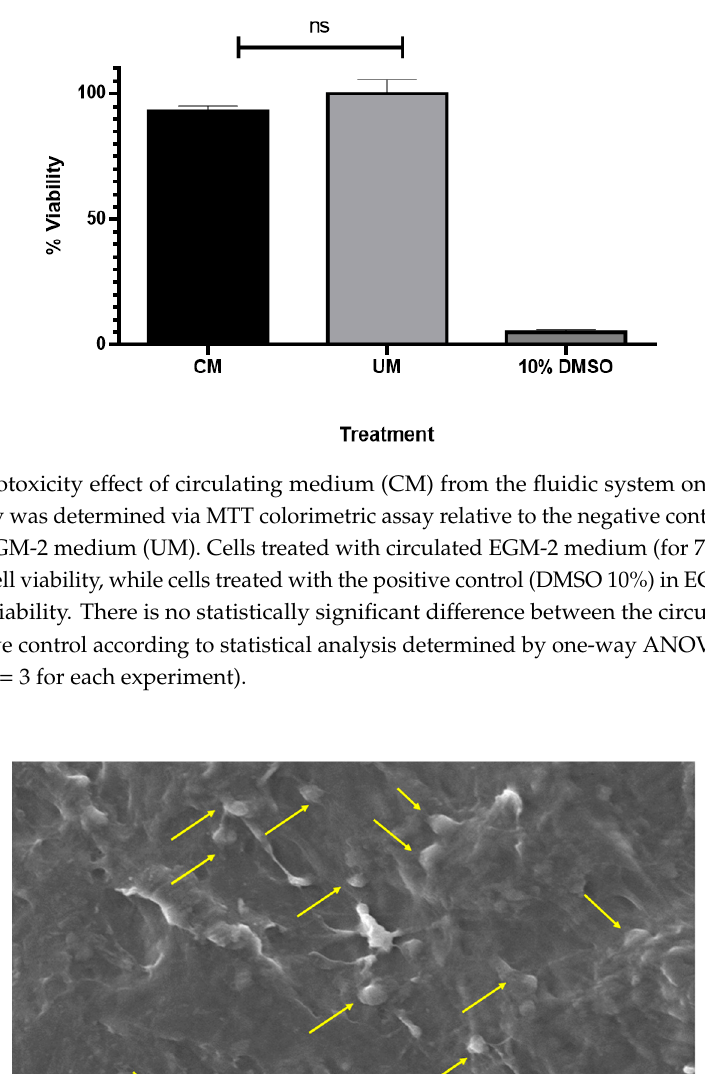
Figure 19. Scanning Electron Microscopy (SEM) imaging of HUVEC cells attachment on the surface